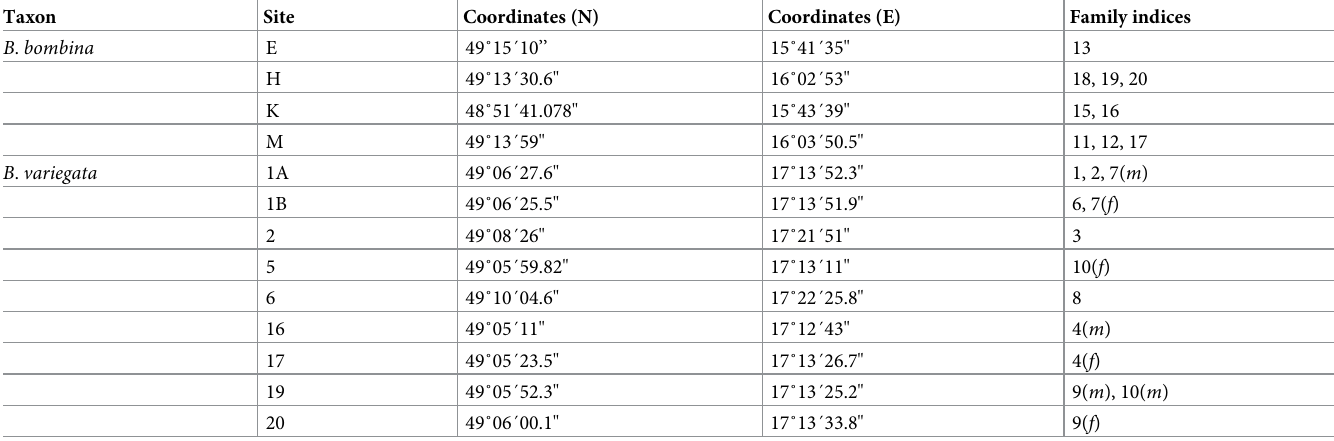
Table 1. Collection sites and pairing scheme.